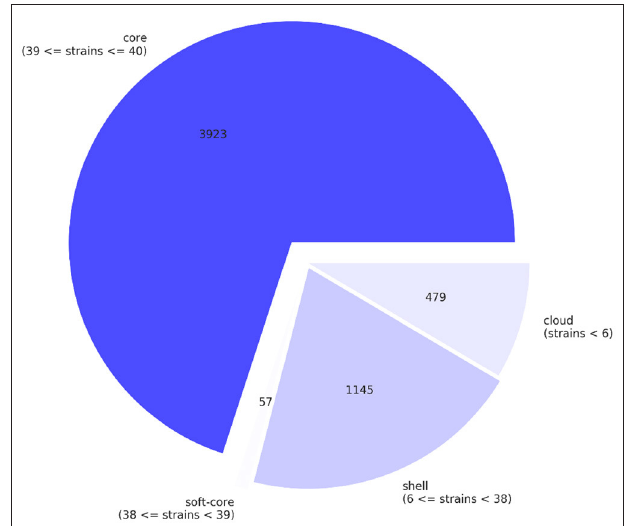
FIGURE 1 | The pan-genome of the retail Salmonella isolates, core genes, shell genes, and cloud genes were identified by comparing the isolates.